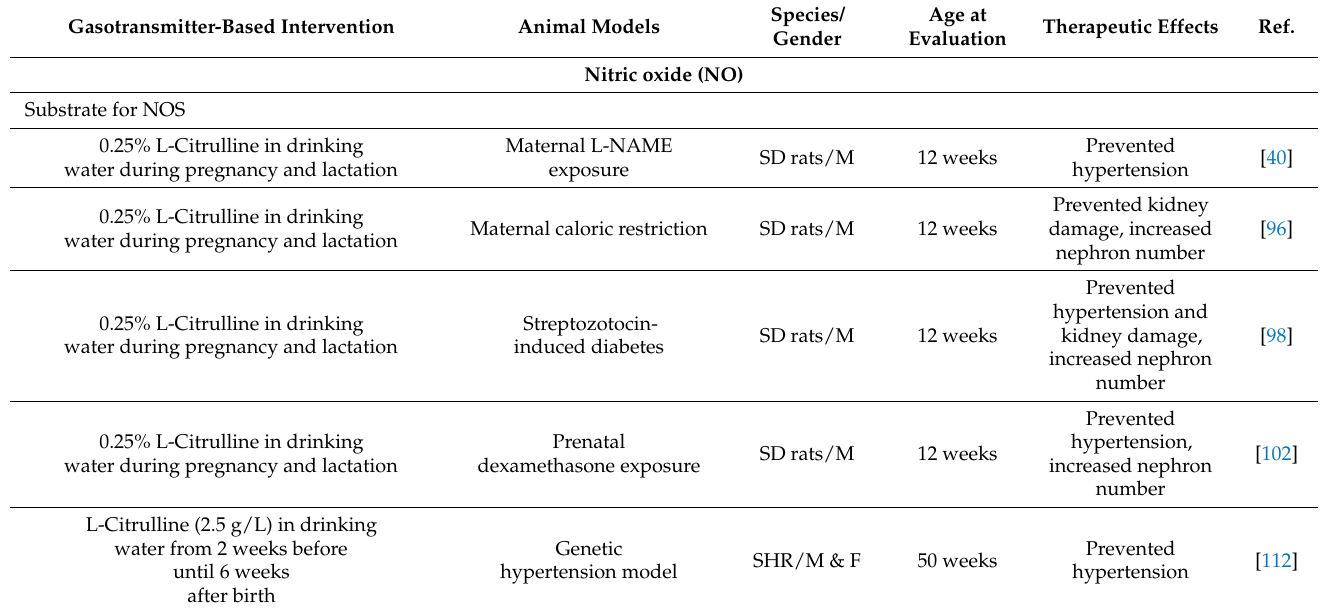
Table 3. Summary of gasotransmitter-based interventions used for therapeutic prevention of hypertension and kidney disease of developmental